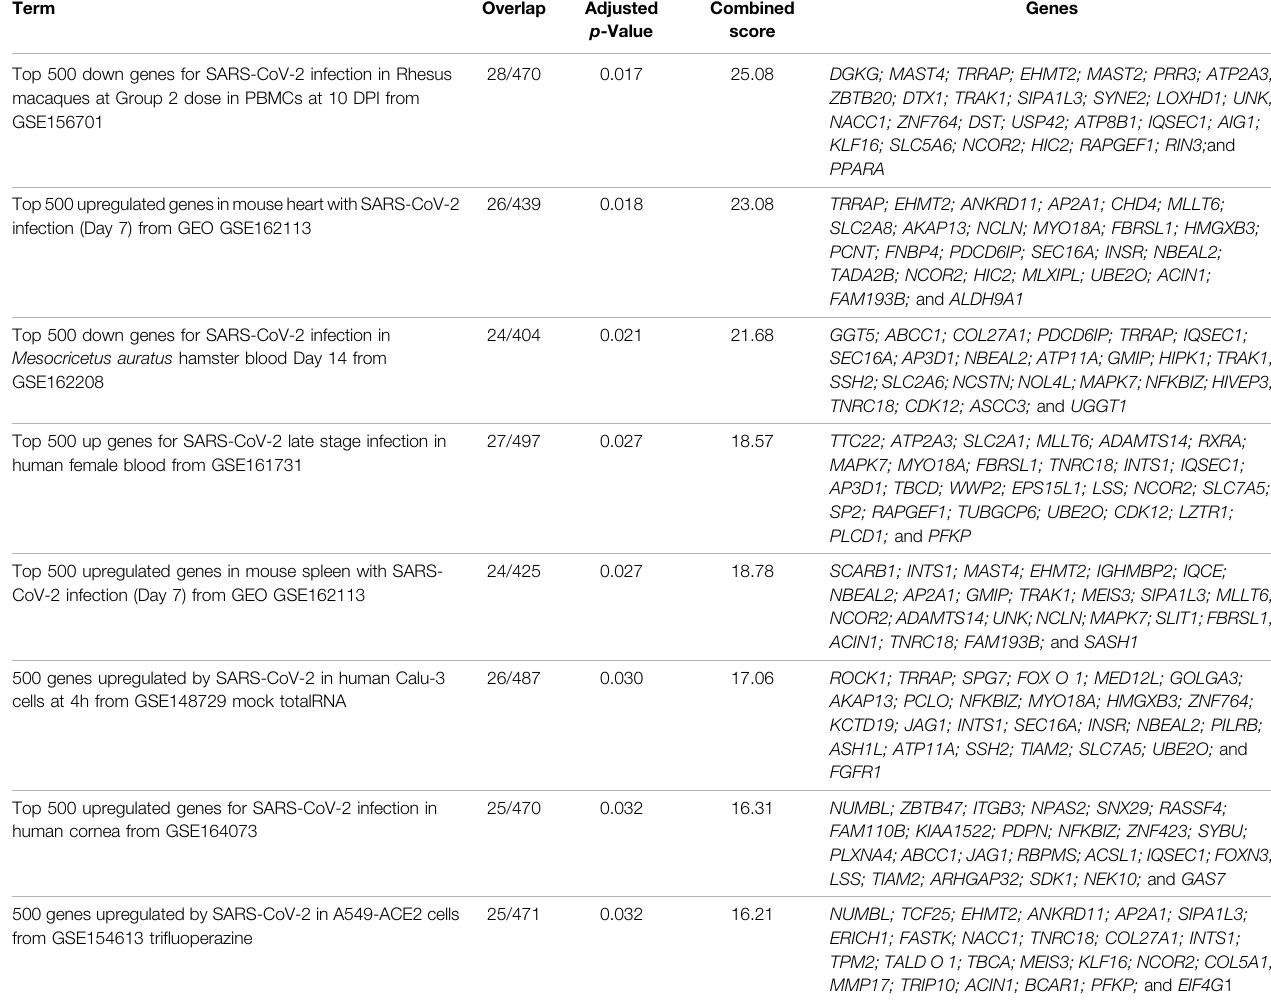
TABLE 2 | Differentially methylated loci overlapping with enrichr COVID-19-related gene sets 2021.